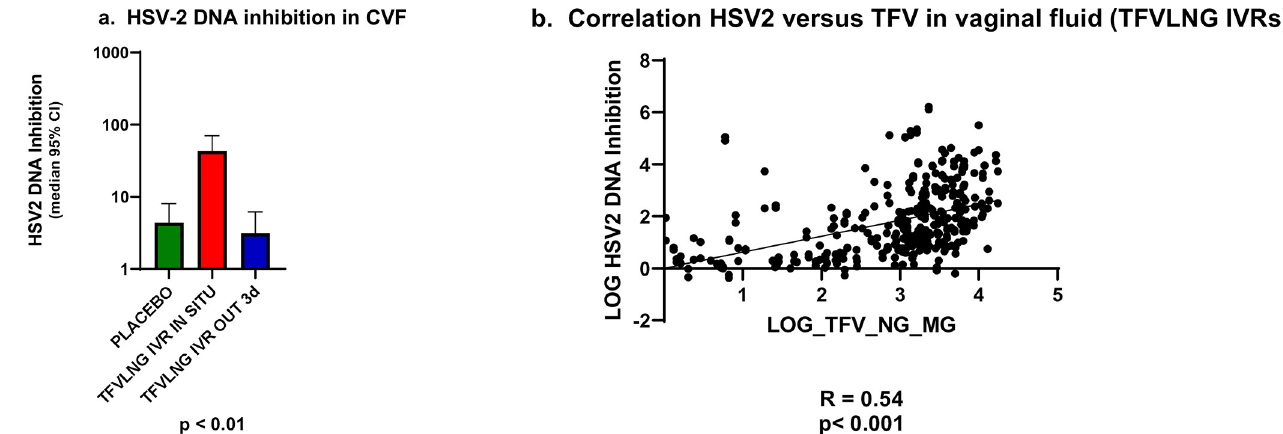
Fig 5. a. Median (IQR) HSV2 DNA inhibition. b. Correlation HSV2 inhibition versus TFV in vaginal fluid (TFVLNG